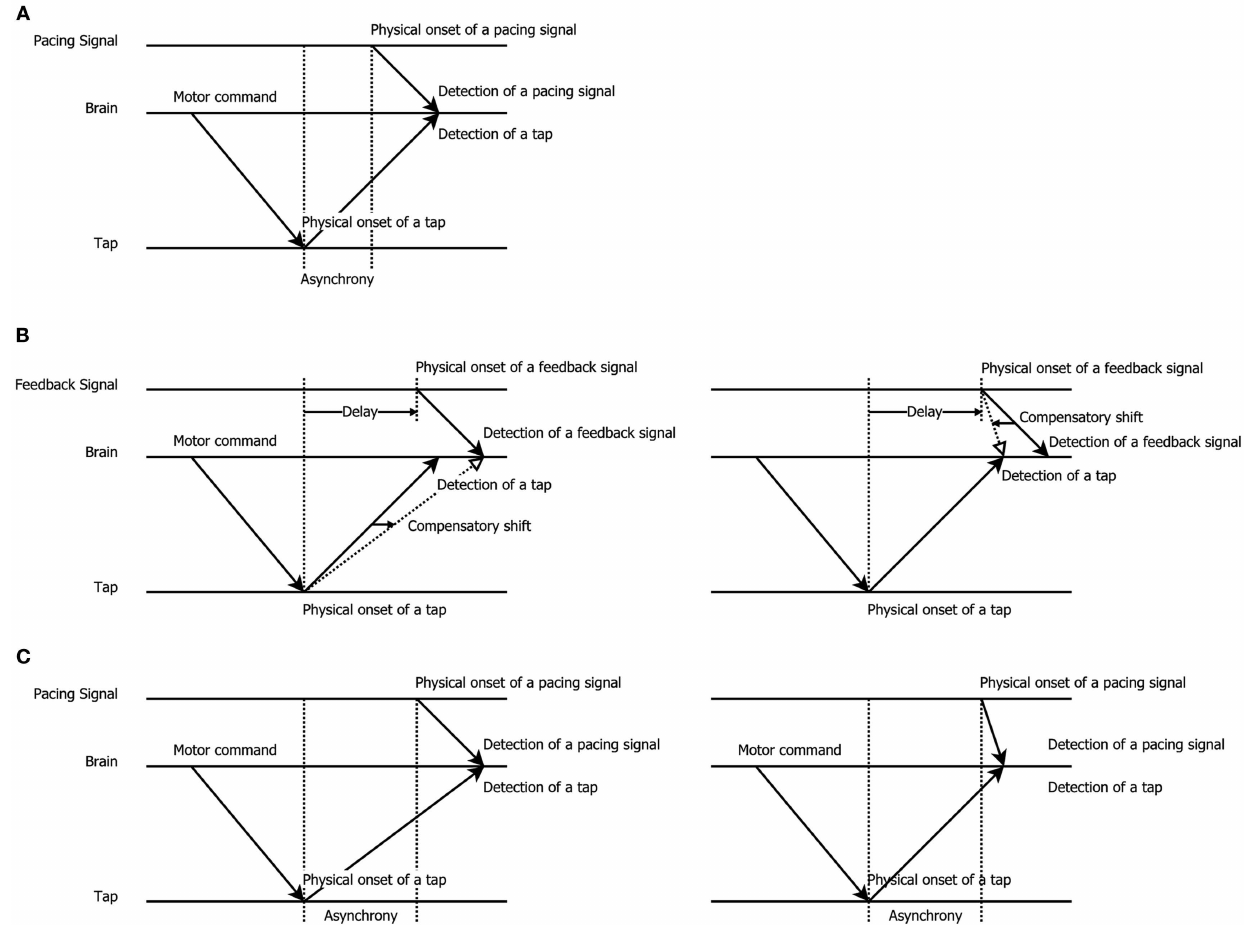
FIGURE 1 | Schematic illustration of the shift in tapping asynchrony after exposure to delayed feedback, modified fromAschersleben and Prinz (1997). (A) Synchronous tapping before adaptation: the latency difference between detection of a pacing signal (sound or flash) and tap gives rise to a tap asynchrony (tap-before-pacing-signal; Paillard–Fraisse hypothesis, Paillard, 1949; Fraisse, 1980; Aschersleben and Prinz, 1997). (B) Exposure to delayed